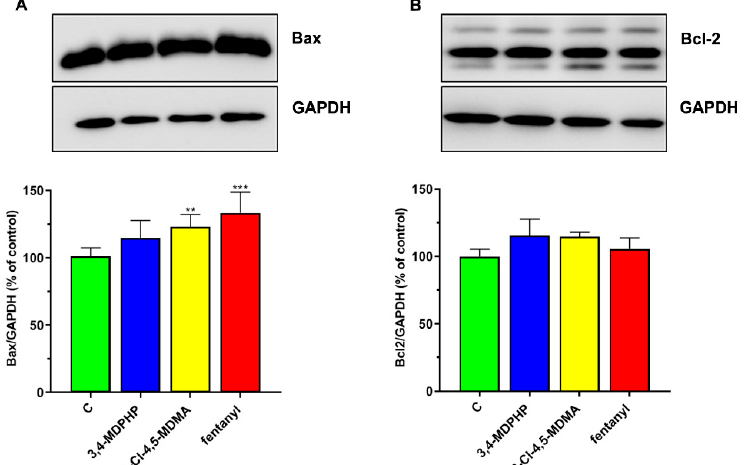
Figure 7. Expression level of Bcl2 and Bax proteins in dopaminergic-differentiated SH-SY5Y cells